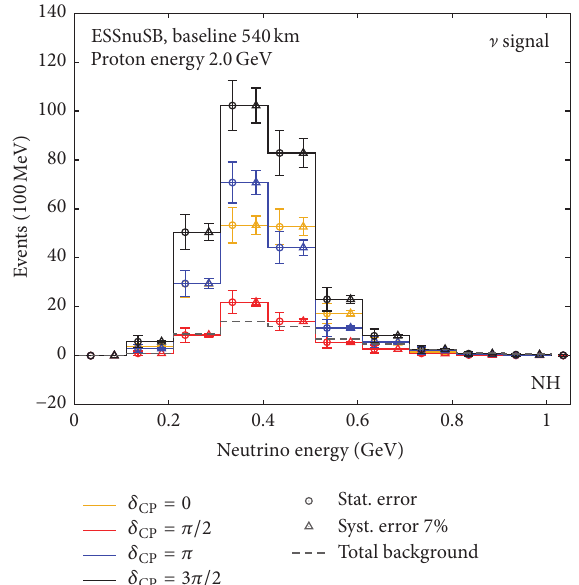
Figure 3: Histograms showing, for a baseline of 540 km and a proton energy of 2.0 GeV, the energy distribution for the electron neutrinos detected during 2 years of data taking for three different values of 𝛿 CP